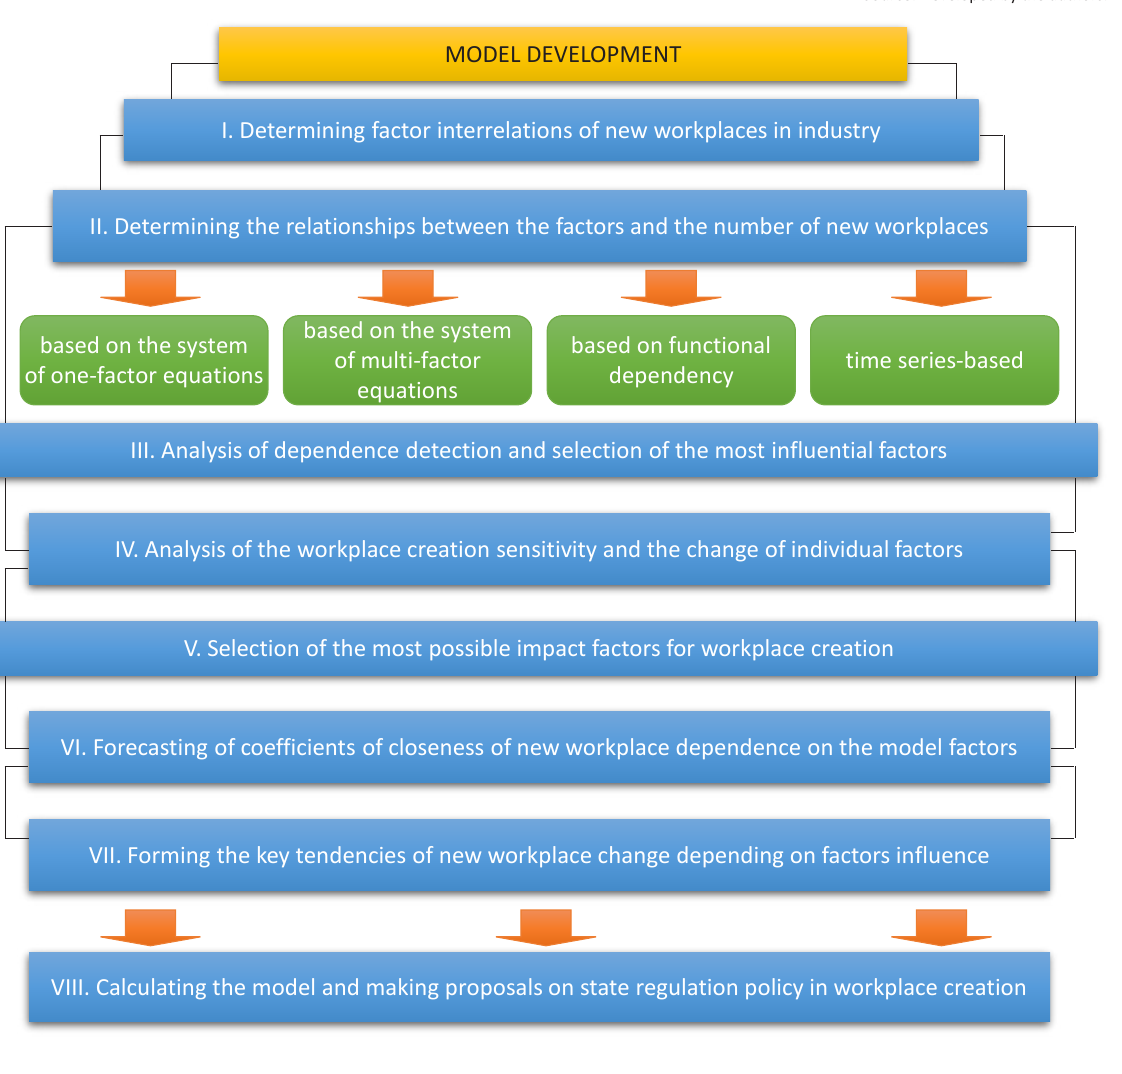
Figure 1. A model for assessment of new workplace dynamics in